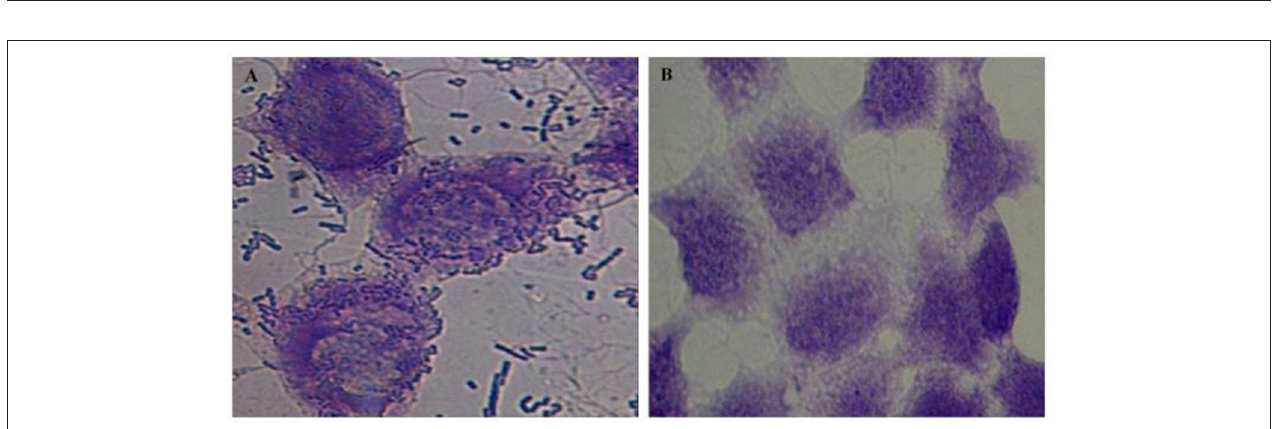
FIGURE 8 | Percentage auto-aggregation exhibited by lactobacilli isolates. Bars represent the mean, error bars represent standard deviation of three independent experiments and **significance ( p < 0.0001) was measured by using paired Student’s t -test.